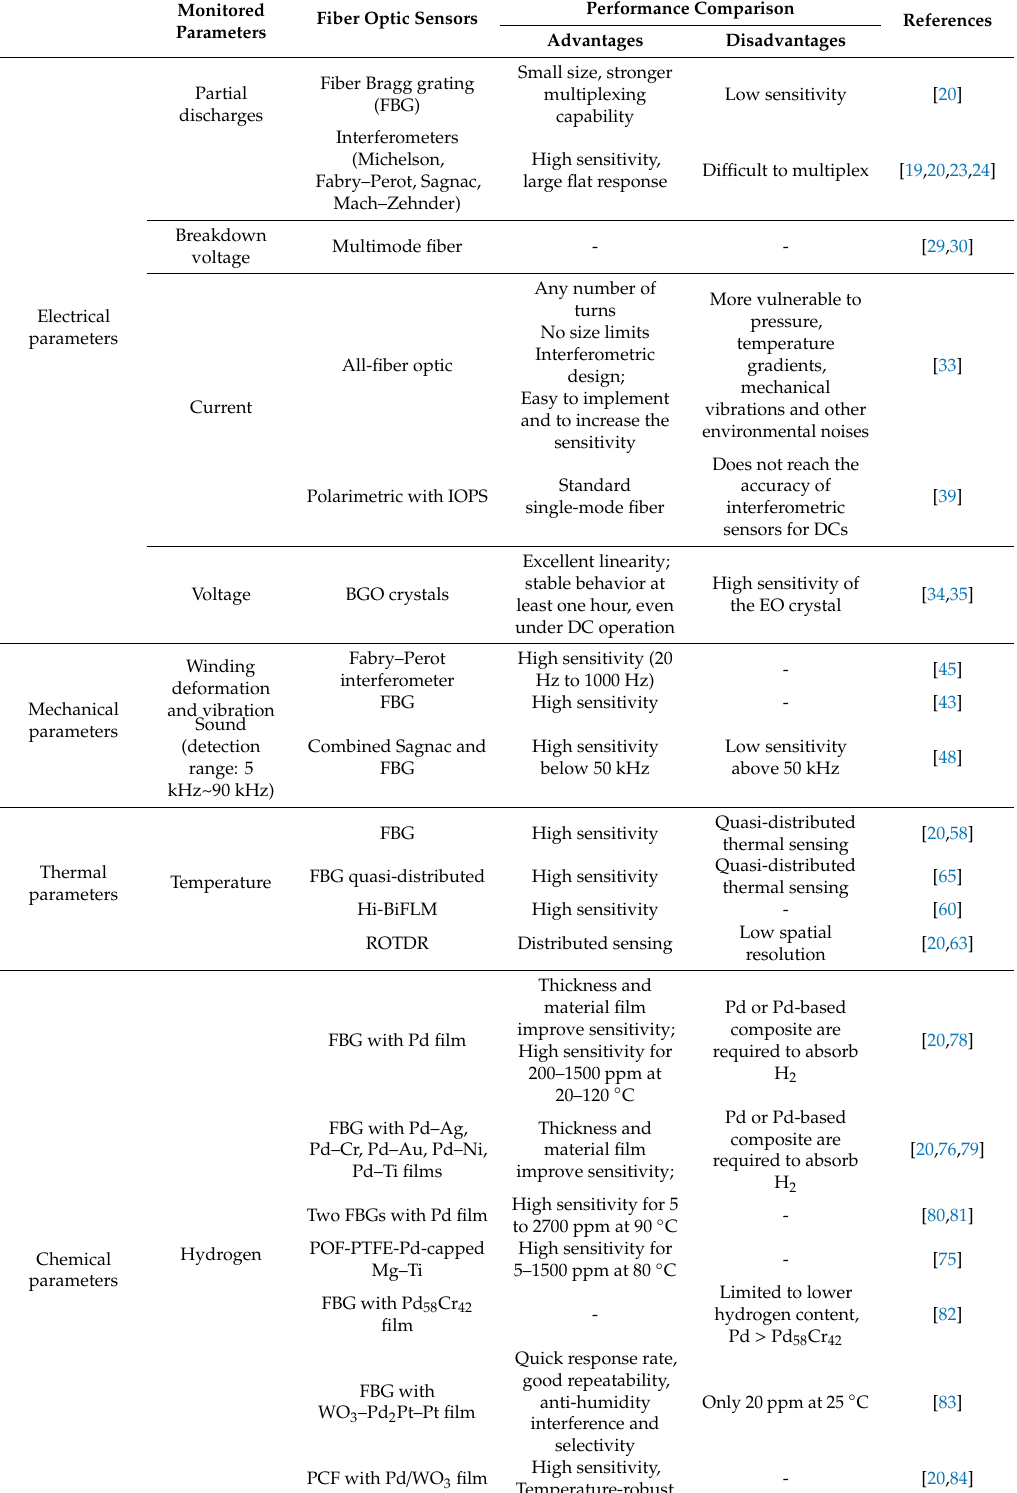
Table 2. Performance comparison of the fiber optic-based sensors used in power